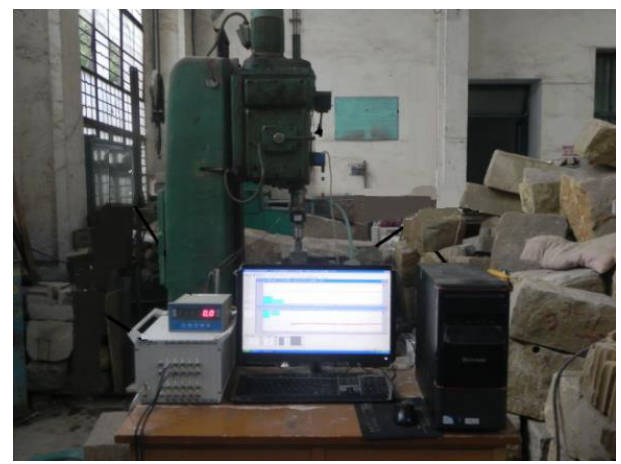
Figure 1. Material abrasiveness machine.